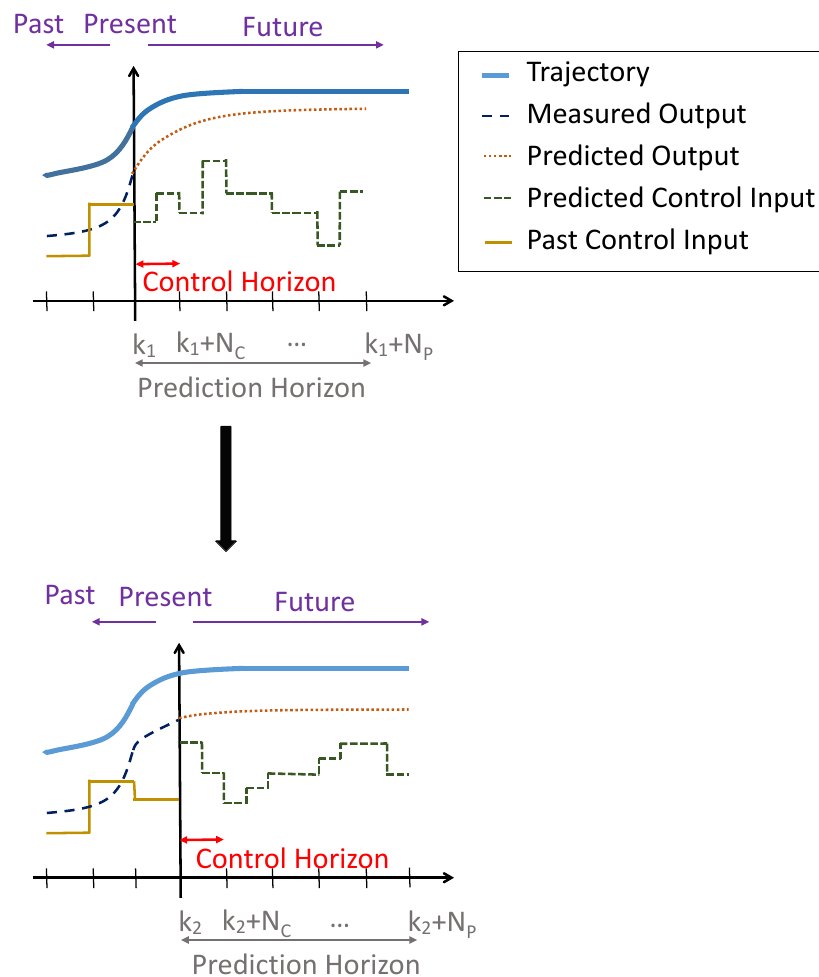
Figure 2. Receding horizons in the MPC